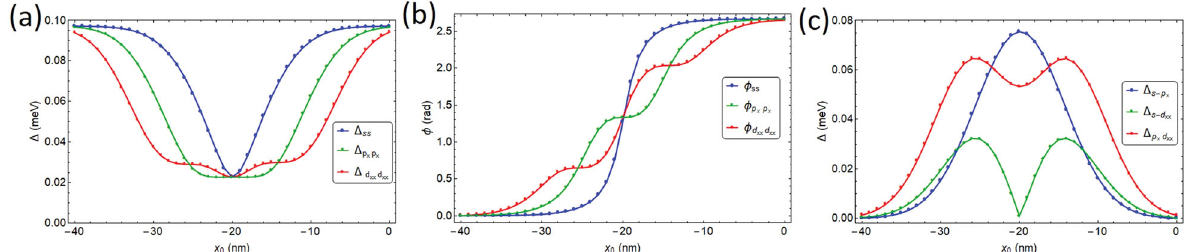
Fig. 4 Valley – orbit couplings as functions of the interface step position. Valley – orbit coupling as a function of the location of a single interface step. a and b present the magnitudes and phases of the diagonal valley – orbital coupling elements in Eq. (2), respectively, while c shows the magnitude of the off-diagonal terms of the valley – orbit coupling matrix of Eq.